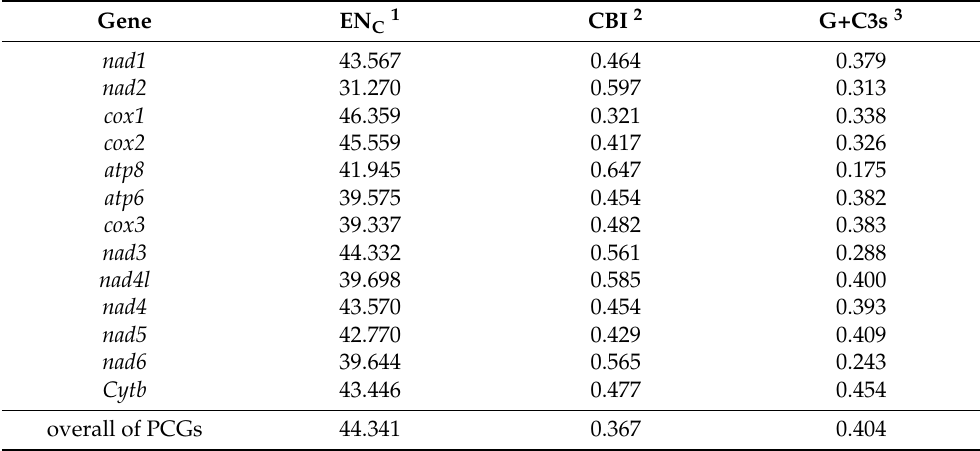
Table 3. Codon bias indicators revealed for protein-coding genes found in the mtDNA of European mink.